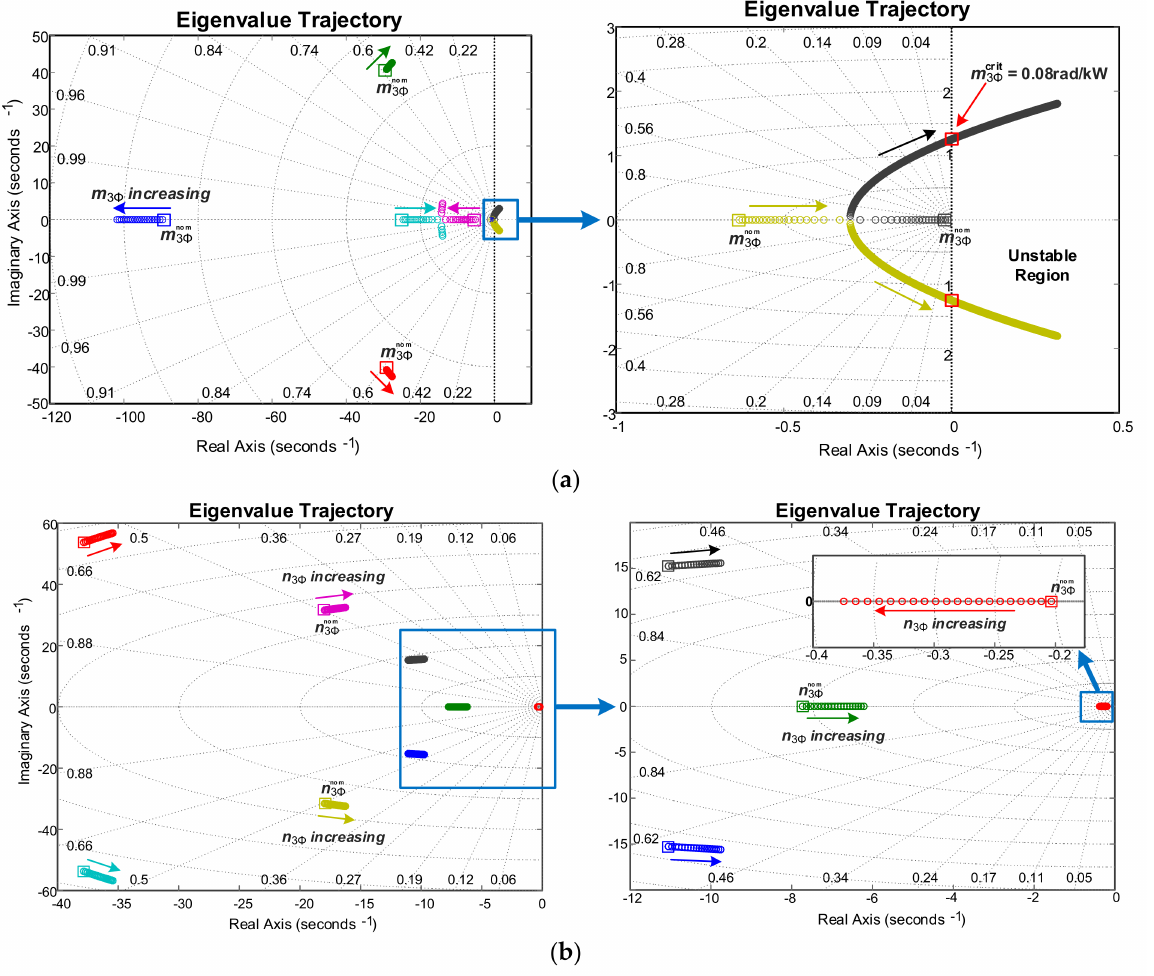
Figure 17. Eigenvalue trajectory for variation of droop coefficients ( a ) m MG , ( b ) n MG .